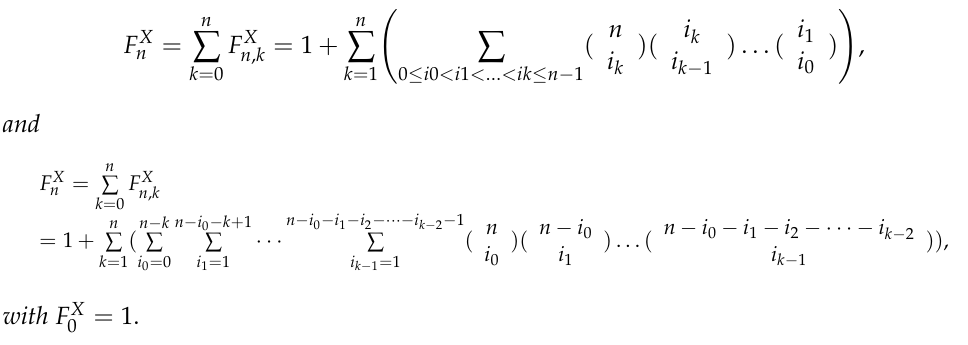
∅ (= F X ) for 0 ≤ k ≤ n , n ≤ n n